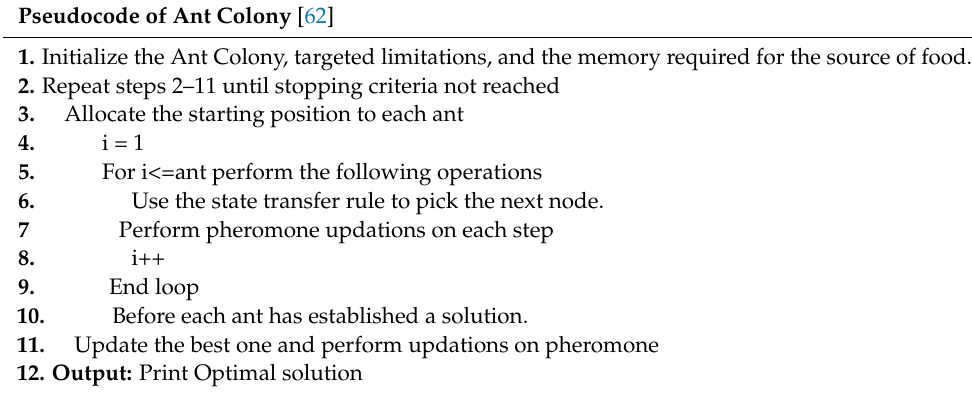
Figure 7. Environment of ant colony optimization [41]. The steps involved are presented in the algorithm.